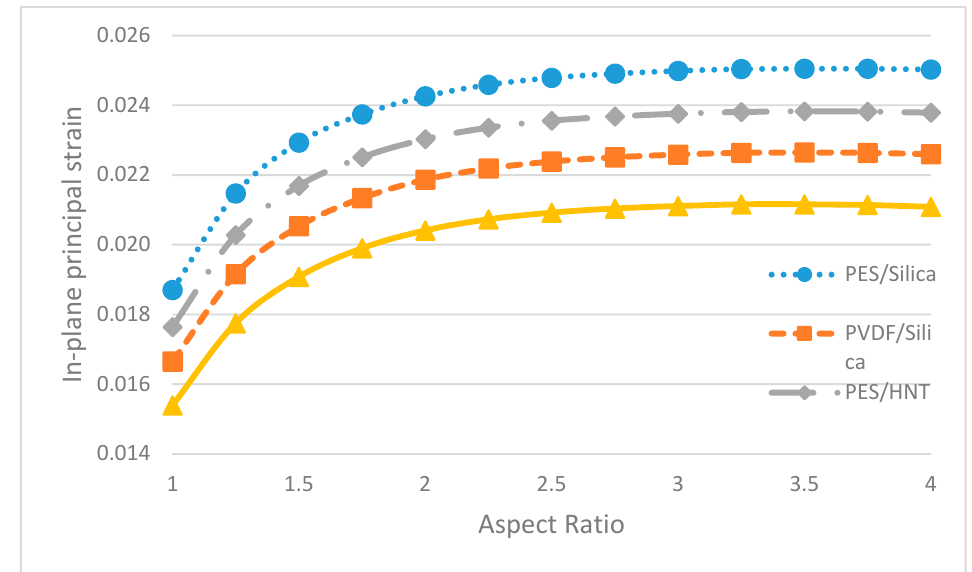
Figure 19. The maximum in-plane principal strain of nanocomposite membranes with different aspect ratios.